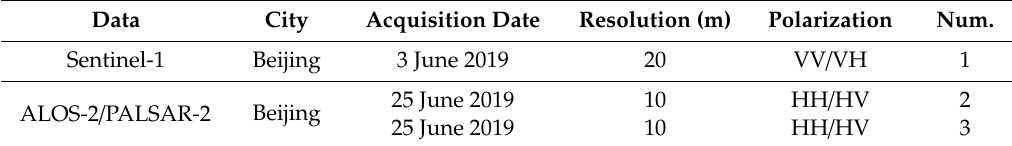
Table 2. Basic information of Sentinel-1 and ALOS-2 / PALSAR-2